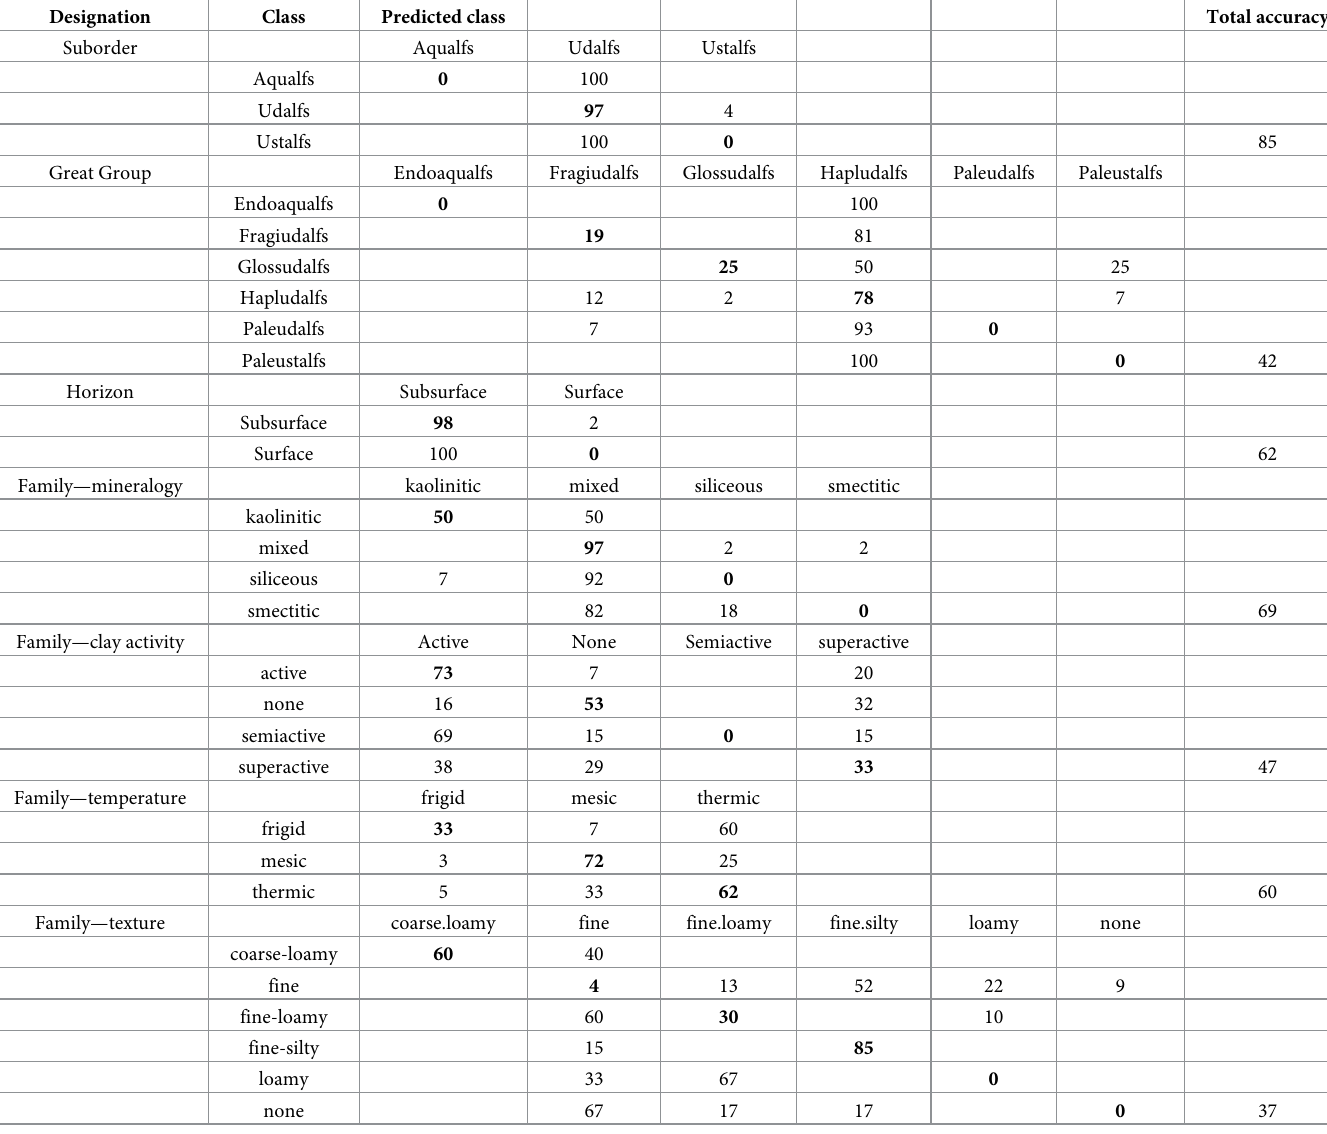
Table 4. Misclassification matrix from linear discriminant analysis testing the accuracy of the 2-PC model used to describe the particle size composition to correctly assign class memberships of the Alfisols samples among the different Great Group taxonomic designations. Percent correct classifications are shown on the diagonal (in bold) while percent misclassification samples are shown